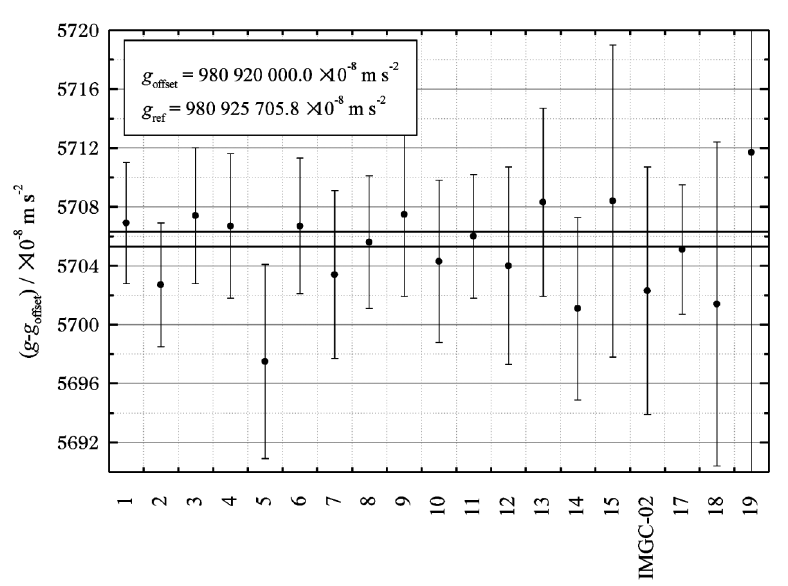
Fig. 3. Results of the last International Comparison of Absolute Gravimeters (ICAG05). Errors bars represent the measurement expanded